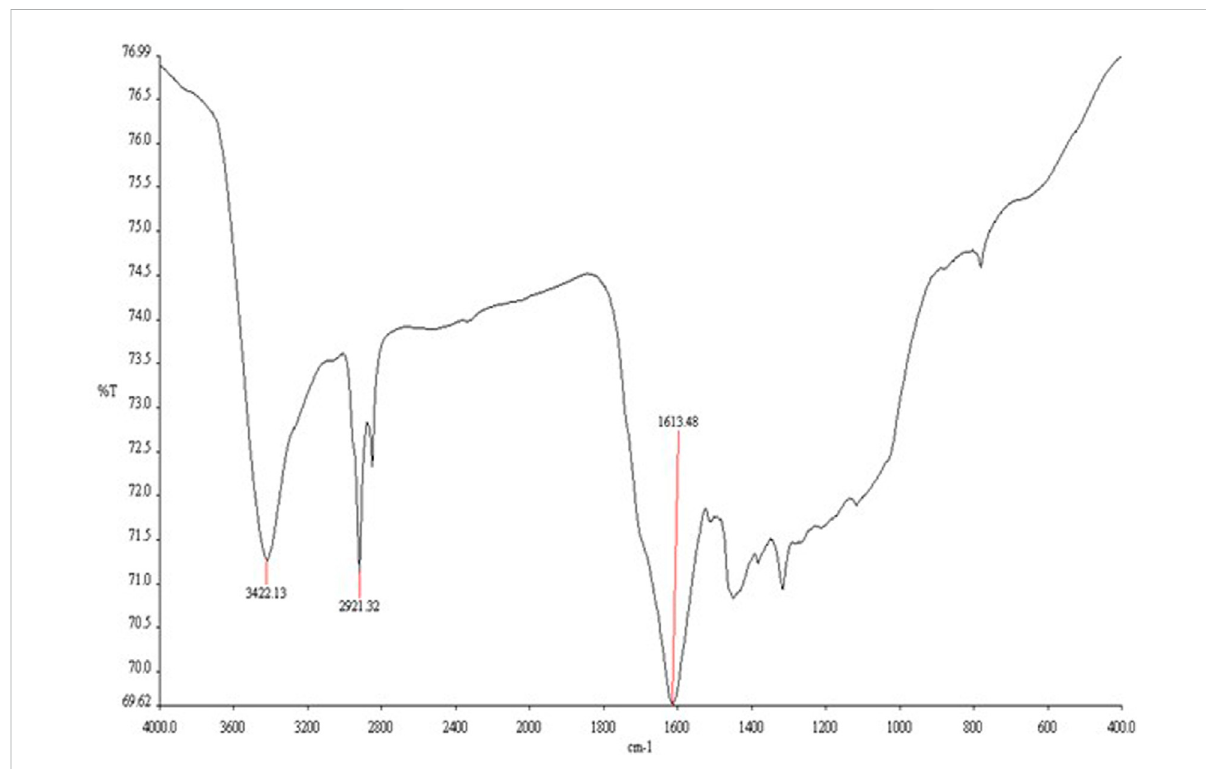
FIGURE 2 FTIR spectrum of Cannabis sativa